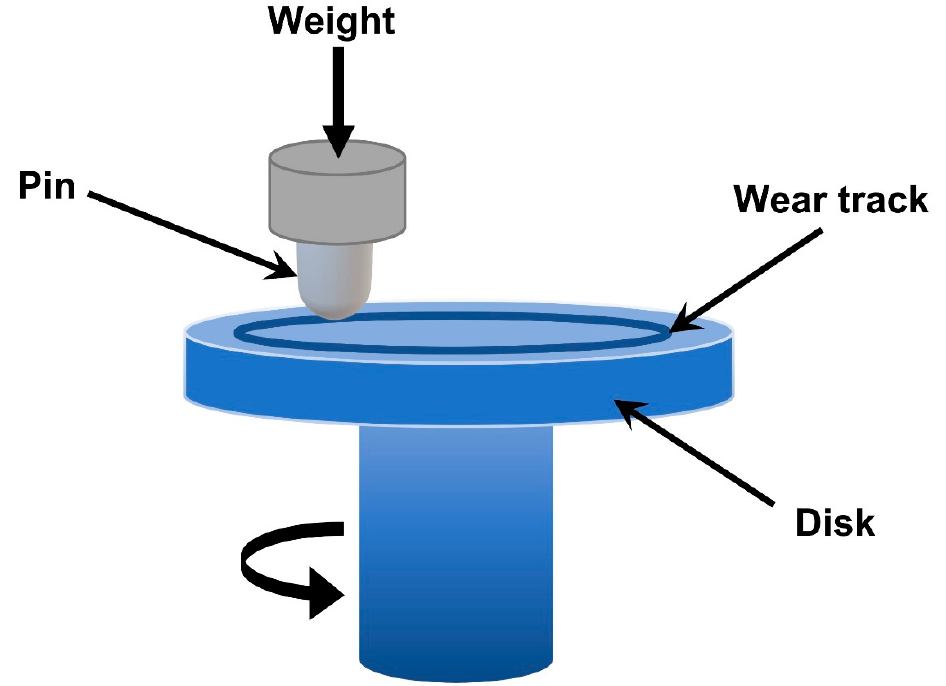
Figure 4. Schematic diagram of the pin-on-disk device.